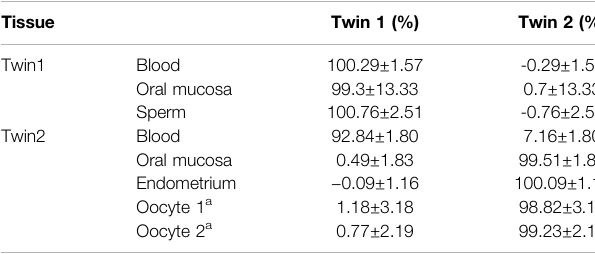
TABLE 1 | ddPCR result of different tissue in twin 1 and twin